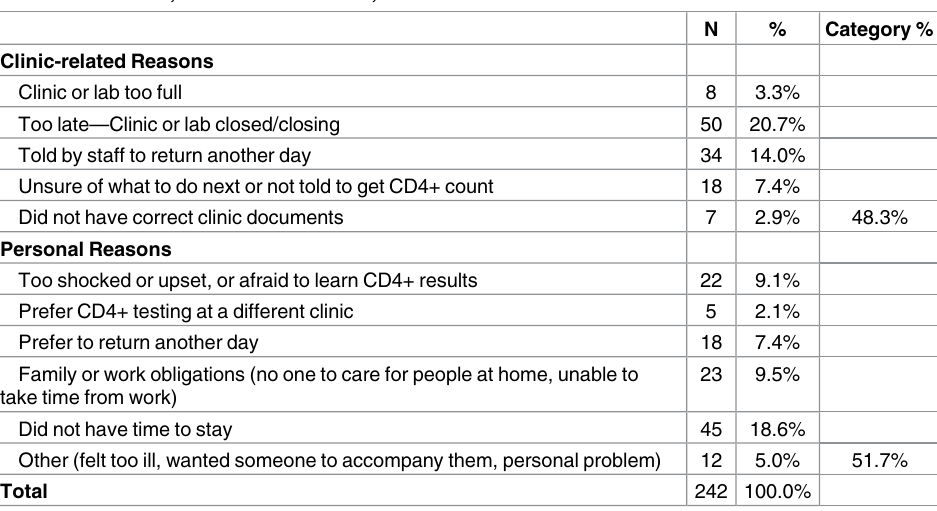
A clinic-related reason for no day-of-diagnosis blood draw was associated with a crude HR of 0.59 (95% CI: 0.43, 0.80) relative to those with a day-of-diagnosis blood draw; a linkage personal reason was associated with a crude HR of 0.49 (95%CI: 0.35, 0.68) (Table 3, linkage lower left panel) The respective AHR for a clinic-related reason was 0.60 (95%CI: 0.44, linkage 0.82), and for a personal reason it was 0.53 (95%CI: 0.38, 0.75), indicating that compared with individuals who had a day-of-diagnosis blood draw, both groups not receiving a day-of-diag- nosis blood draw had lower rates of linkage. Table 2. Reasons for no CD4+ count blood draw on days of diagnosis among newly-diagnosed HIV + women and men, Durban South Africa,